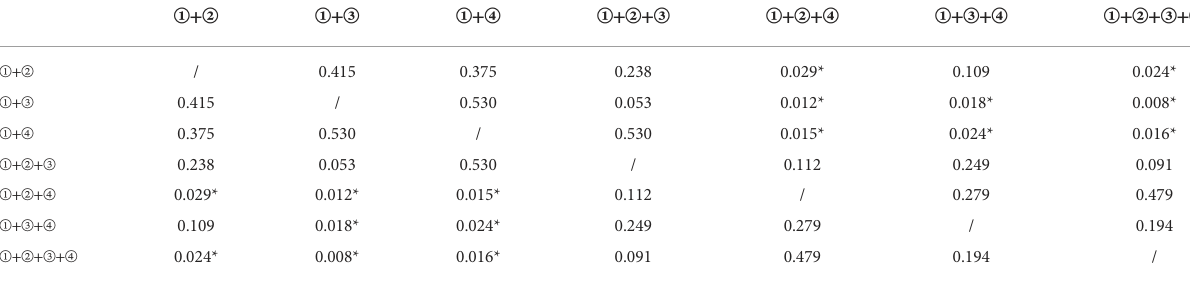
TABLE 4 Differences in the diagnostic ef fi cacy of the multimode ultrasound combination in the training